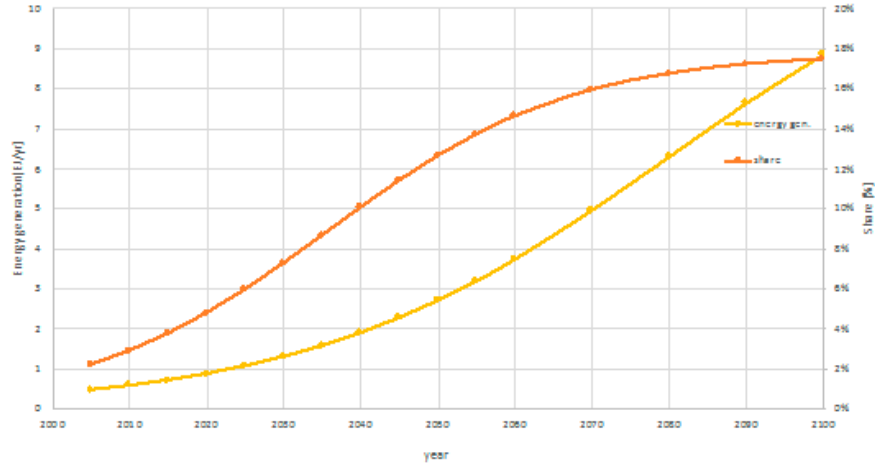
Figure 5. Europe PV technology energy generation development based on the reference scenario of REMIND until the year 2100 (own work).